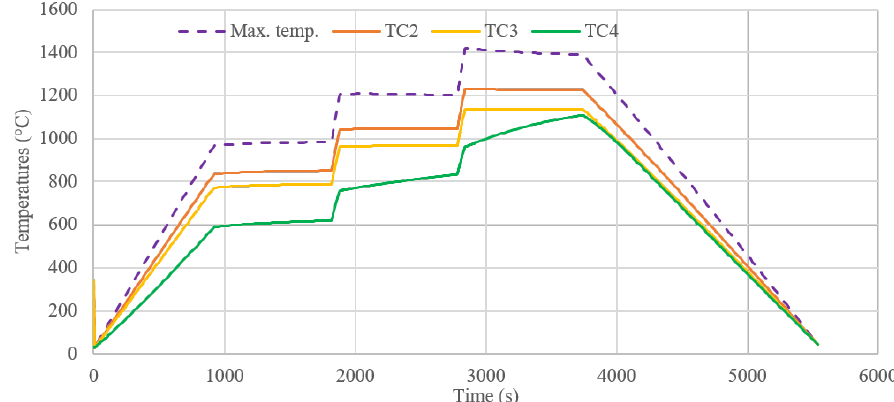
Figure 13. Full simulated thermograms of experiment